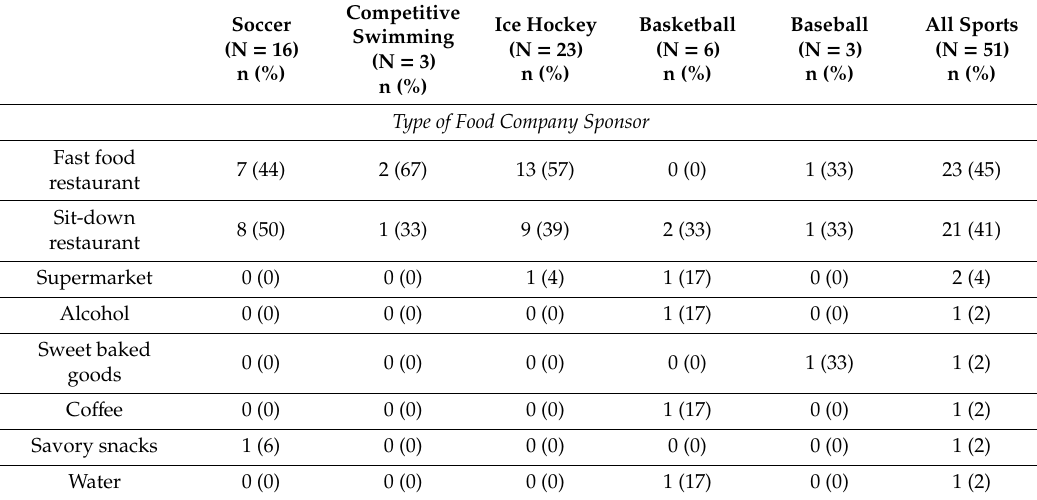
Table 3. Food categories promoted by way of food company sponsorship of children’s sports clubs in Ottawa (Canada), overall and by